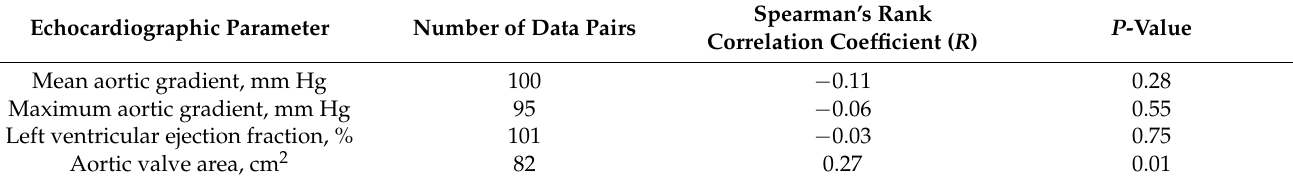
Table 1. Correlations of total serum immunoglobulin E (IgE) levels (IU/mL) with echocardiographic parameters in patients with acquired aortic stenosis ( n = 115).